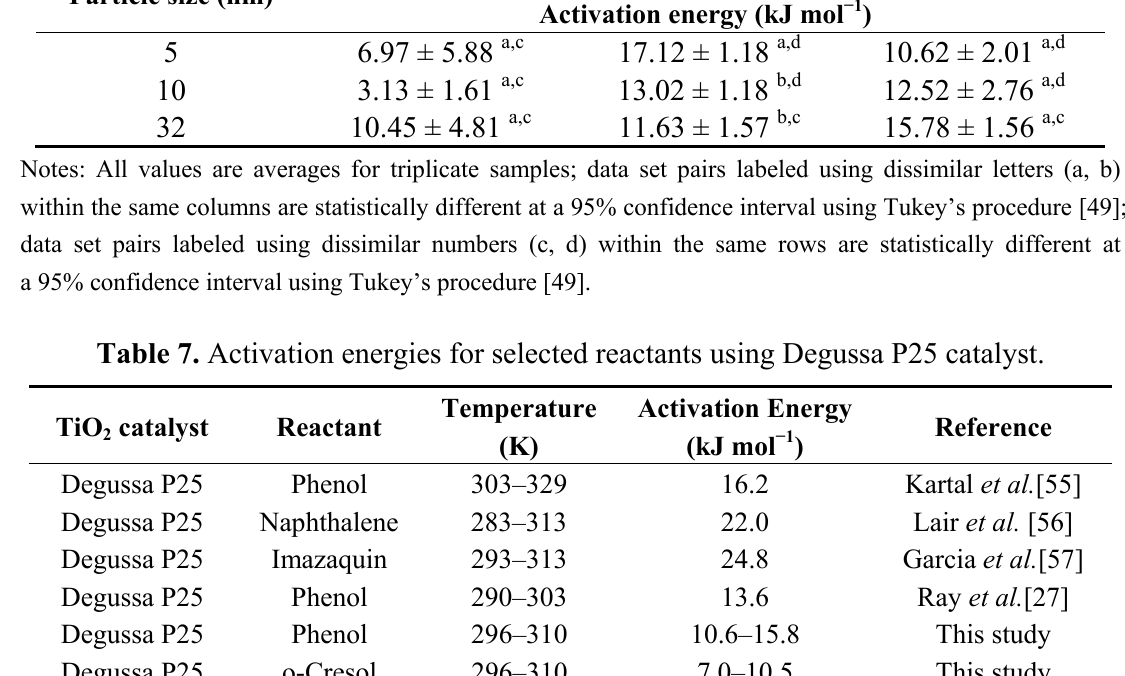
Table 6. Activation energies for o-cresol, m-cresol and phenol for different TiO